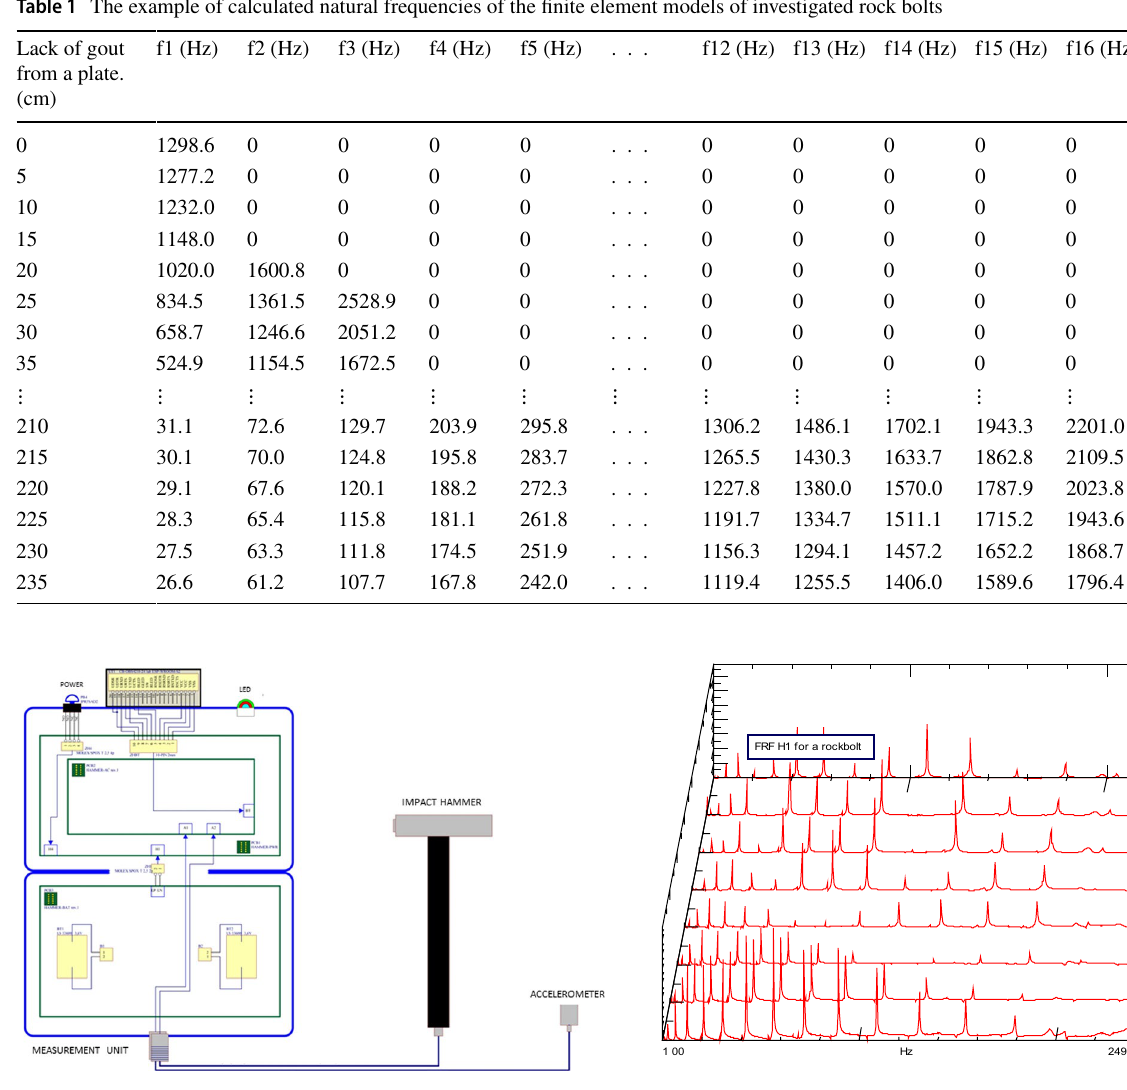
Fig. 6 The FRF functions (waterfall curve) for a diagnosed rock bolt in laboratory